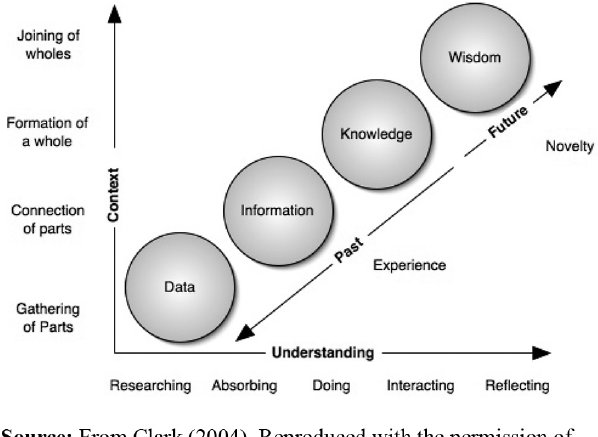
Figure 2. From data to knowledge (the DIKW linear